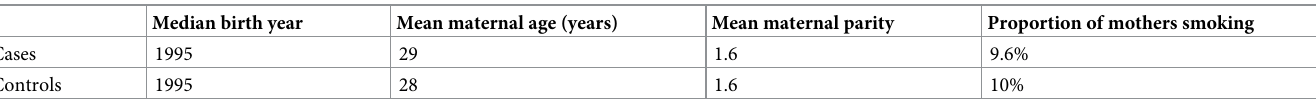
Table 1. Statistics of variables matched for in the studies boys and their